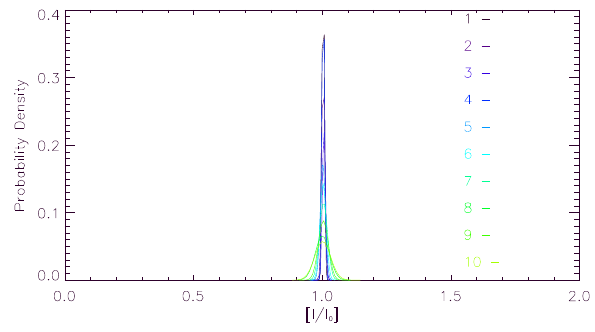
Fig. 7. The normalized intensity distribution for a period of 10s starting at 07:22:00UTC (10 times 1s).